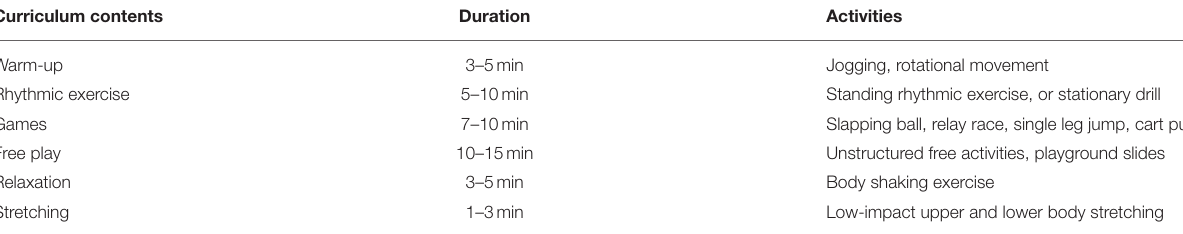
TABLE 2 | Description of the kindergarten-based physical education curriculum.